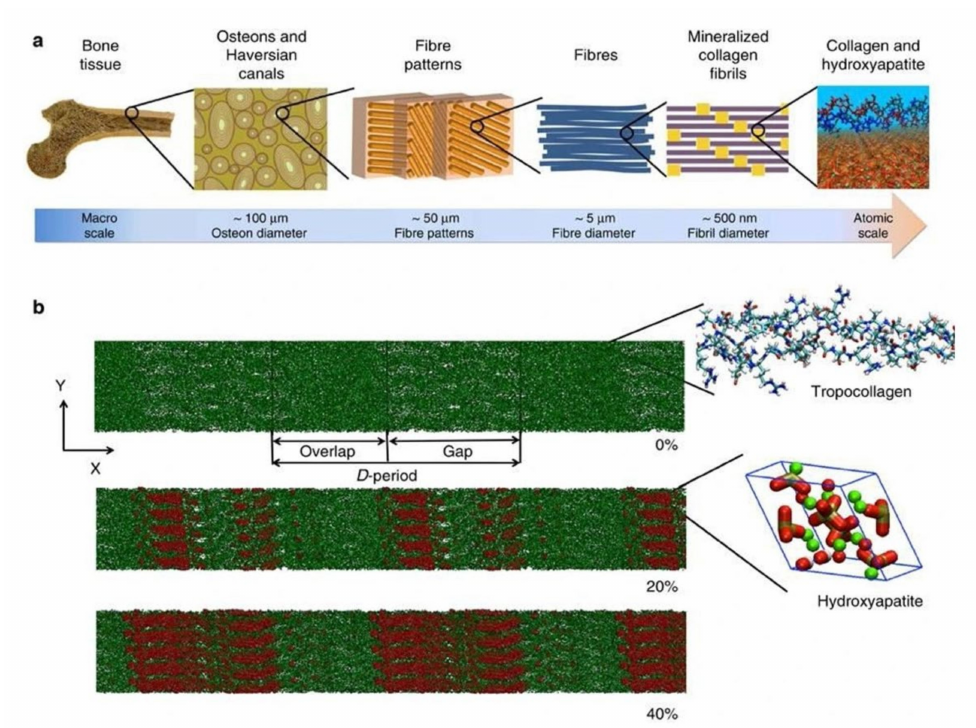
Figure 1. ( a ) Hierarchical structure of bone depicting the arrangement from macro to nanoscale. ( b ) Collagen microfibril model indicating different levels of mineralization from 0% to 40% indicating the alignment of hydroxyapatite crystals. The c-axis of HAP aligns with the collagen fibril axis. Green color indicates Ca atoms, red and white denote OH groups and phosphate groups are visualized in the tetrahedron structure. The image was taken from Arun et al.